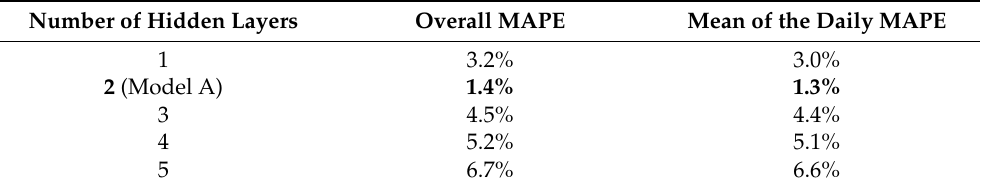
Table 4. The overall and daily MAPE forecast error for the traditional ANN with a different number of hidden layers.